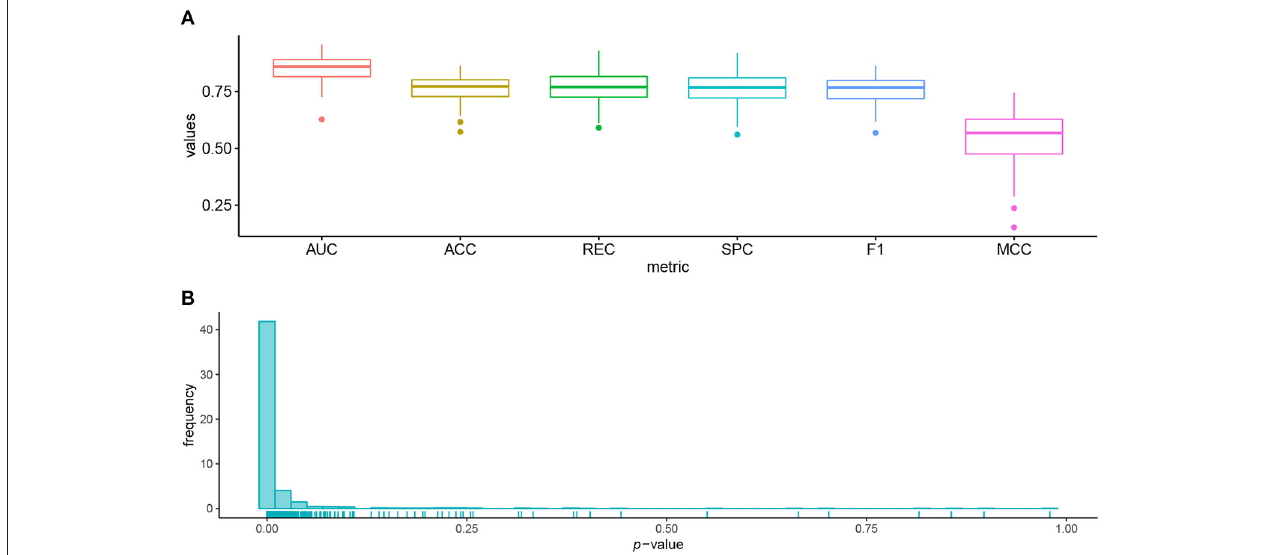
FIGURE 4 | Prediction performance for the lung cell lines in GDSC. (A) Box plots of six metrics overall the lung cells showed the satisfying prediction performance. (B) Histogram of p -values obtained by the statistical significance test for the identified features proved that most of the identified features were of significantly different genetic profiles between the sensitive and non-sensitive populations.